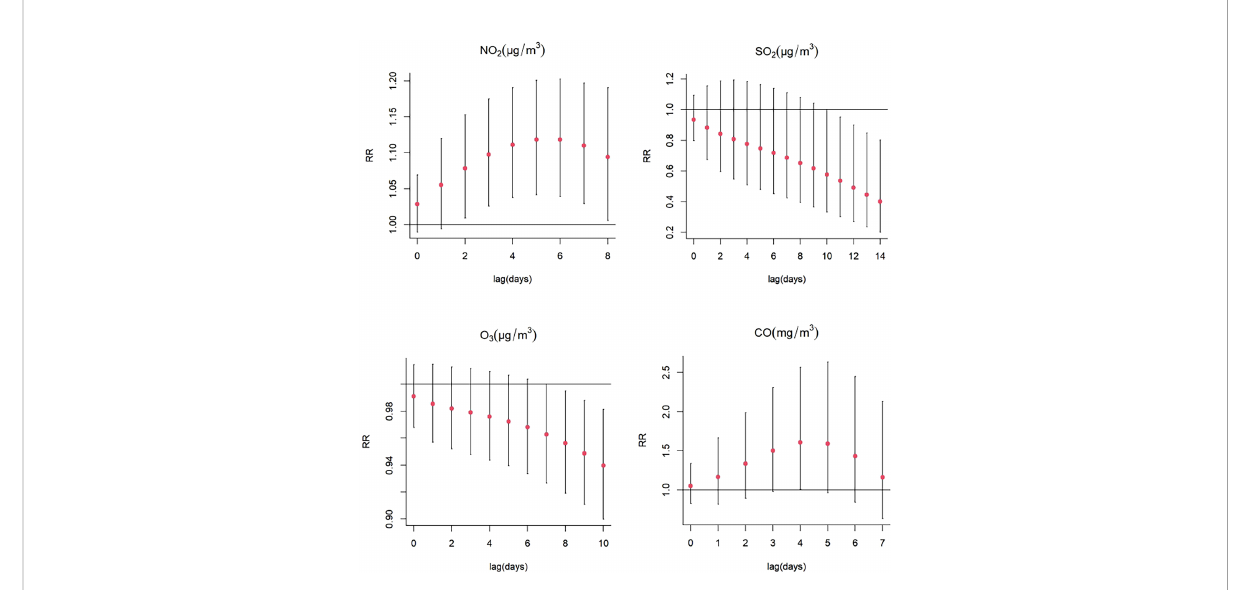
FIGURE 4 Cumulative risks (%) in hospitalizations for SS per 10 (or 1)-unit increase in daily mean concentrations of gaseous pollutants in the